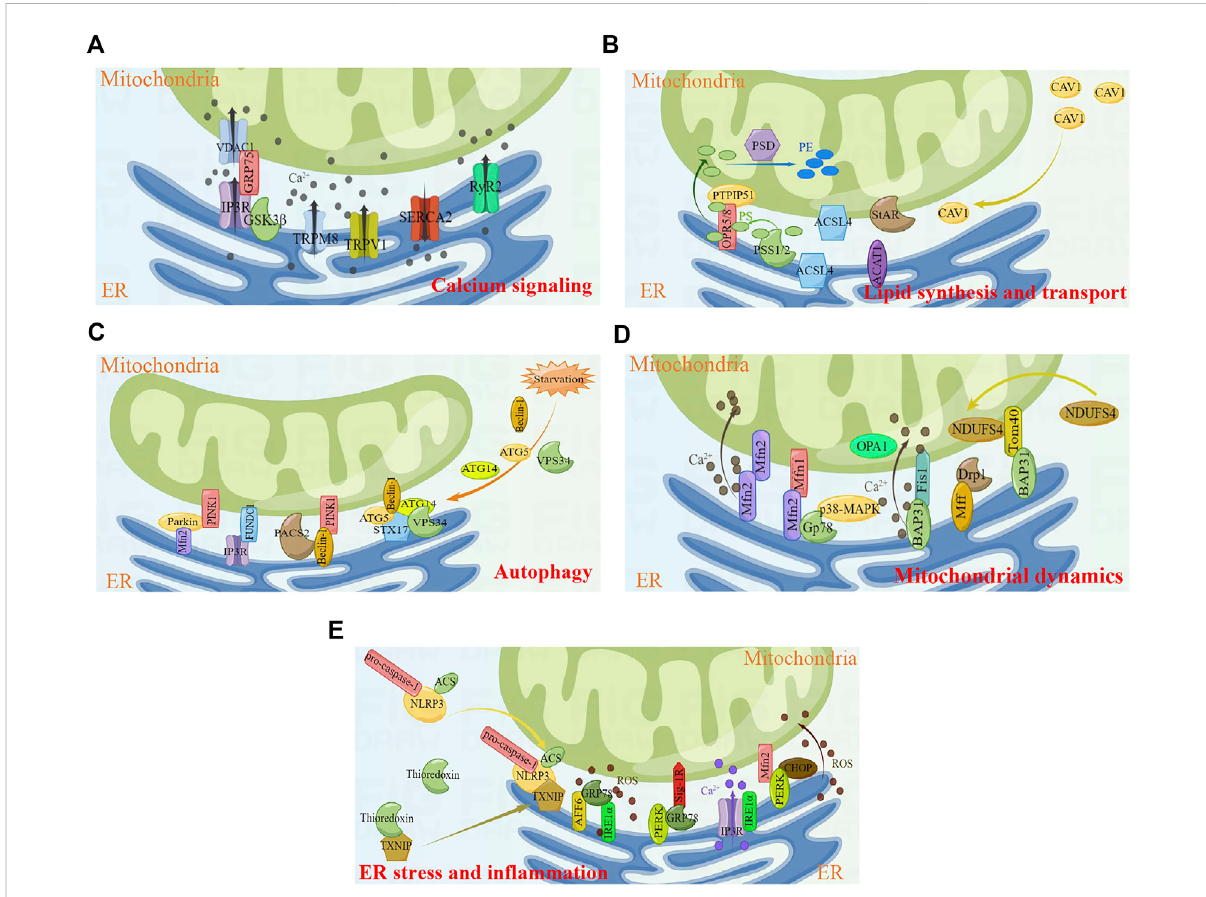
FIGURE 1 Key cellular functions and proteins involved in MERCs. (A) Calcium signaling. (B) Lipid synthesis and transport. (C) Autophagy. (D) Mitochondrial dynamics. (E) ER stress and in fl ammtion. Figures were created using Figdraw. ER, endoplasmic reticulum; MERCs, mitochondria-endoplasmic reticulum